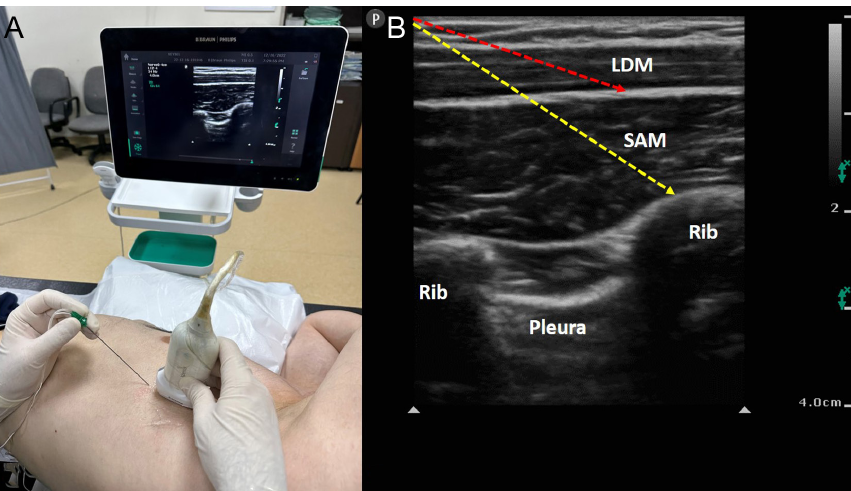
Figure 4. A, B. (A) Patient and ultrasound probe position for serratus anterior plane block procedure. (B) Sonographic anatomy of the block. LDM, latissimus dorsi muscle; SAM: serratus anterior muscle; red arrow, needle direction for superficial serratus anterior plane block; yellow arrow, needle direction for deep serratus anterior plane block.